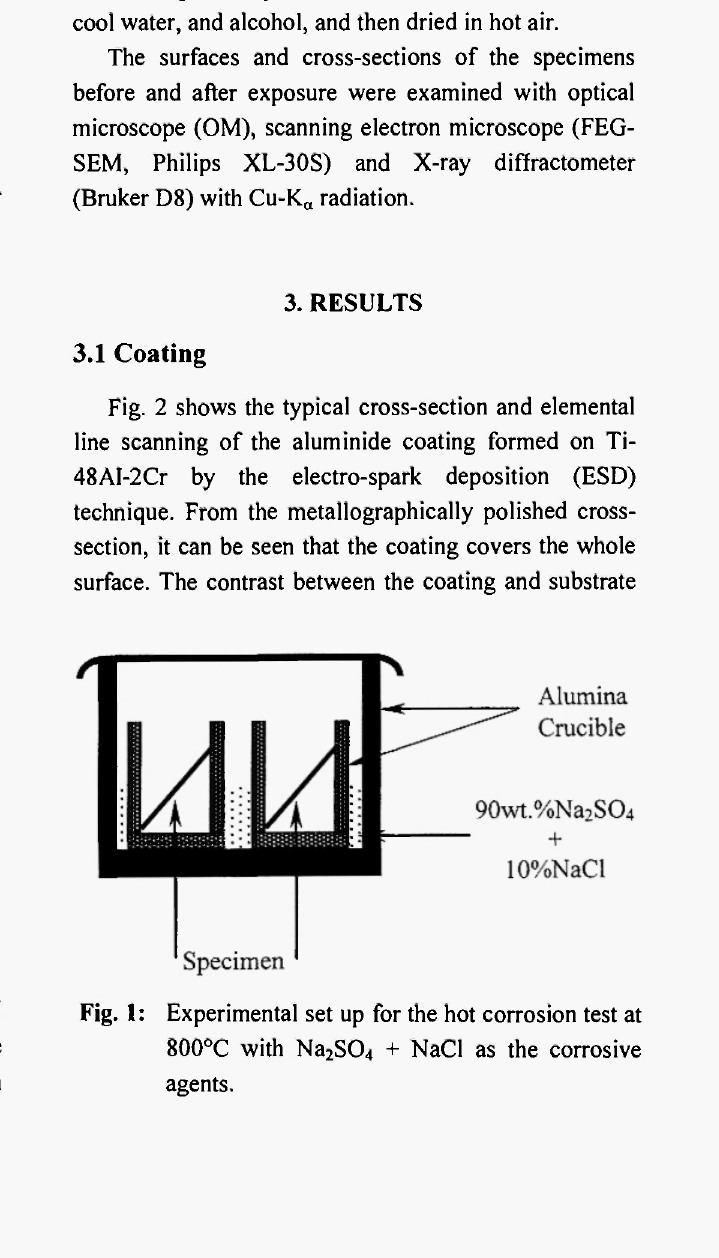
Fig. 1: Experimental set up for the hot corrosion test at 800°C with Na 2 S0 4 + NaCl as the corrosive